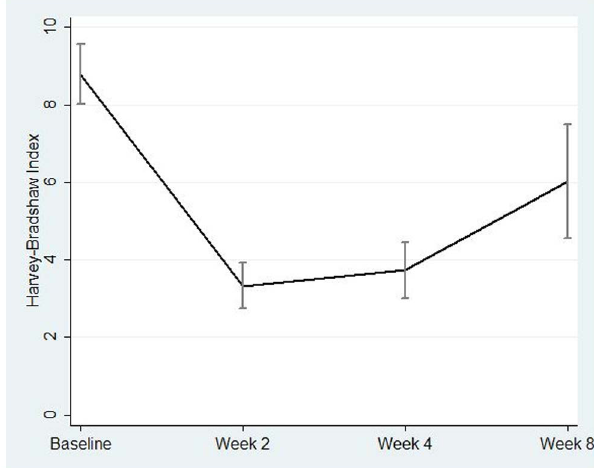
Figure 1. Overtime course of Harvey Bradshaw Index. The line represents the mean score and the error bars represent the standard error at each time point.